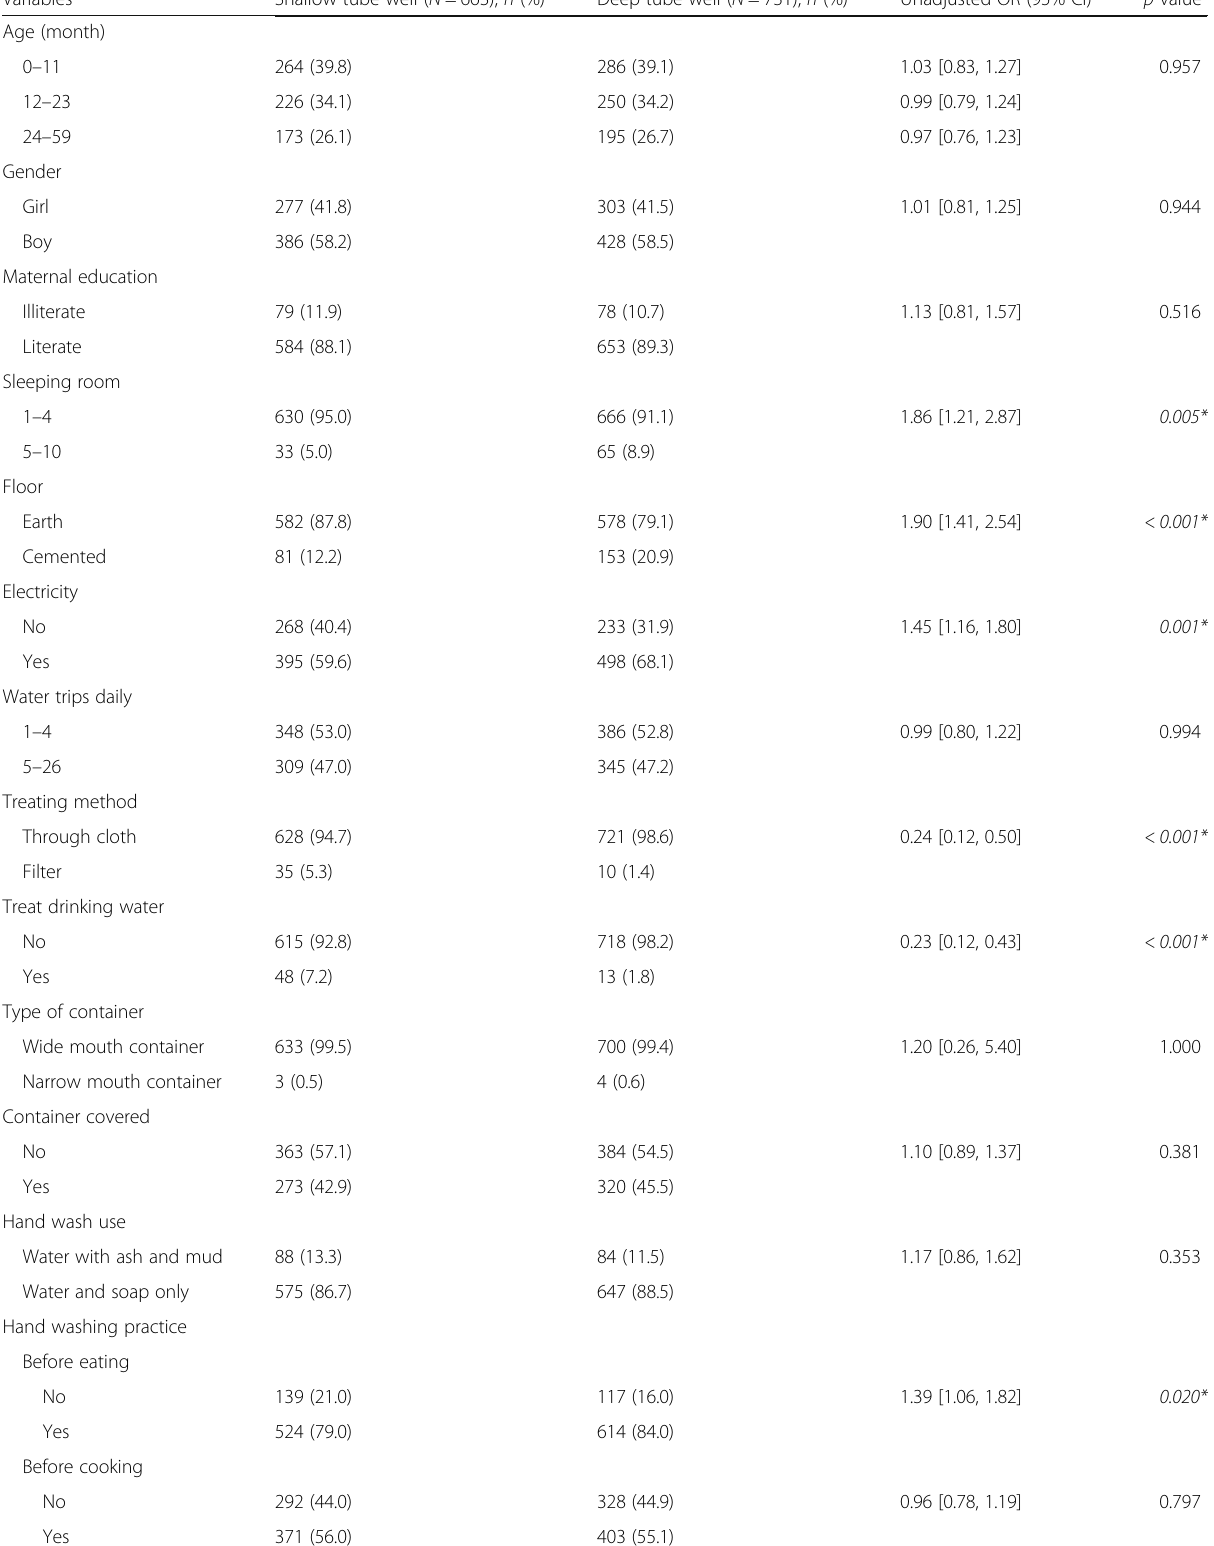
Table 2 Characteristics of under-5 moderate-to-severe diarrheal children from the two types of tube well water-user families